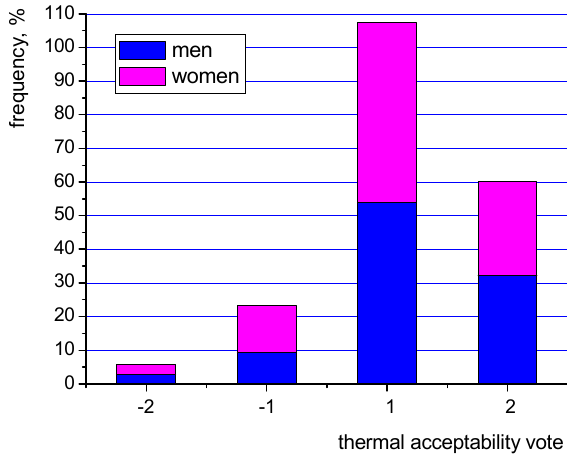
Figure 9. Thermal acceptability of the room occupants in both intelligent buildings based on 1369 questionnaires (description in the text).